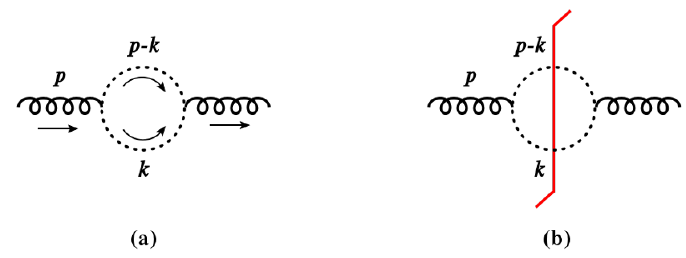
Figure 10 . Gluon vacuum polarization diagram (a) and its cut counterpart (b). Dashed lines correspond to either a quark, a gluon or a